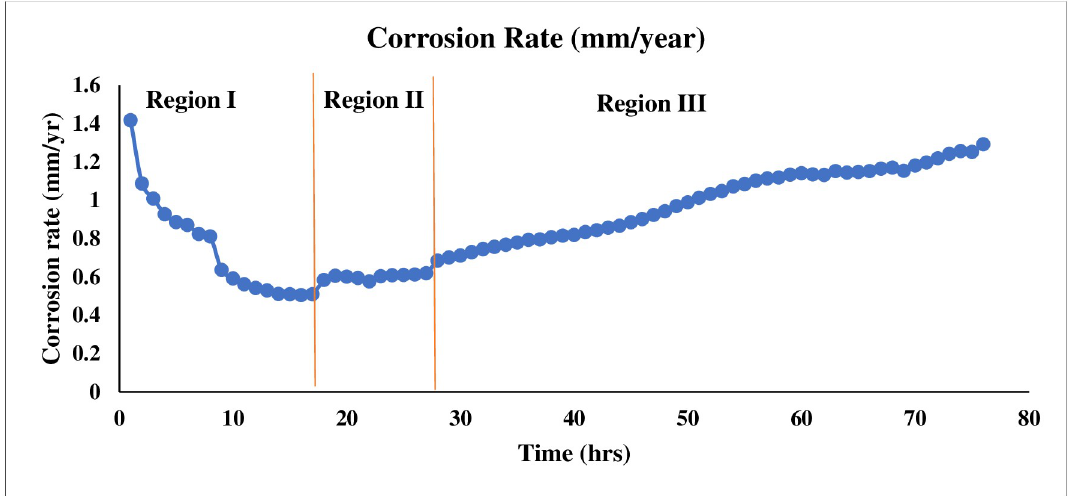
Fig 9. Categorization of severity levels of uniform